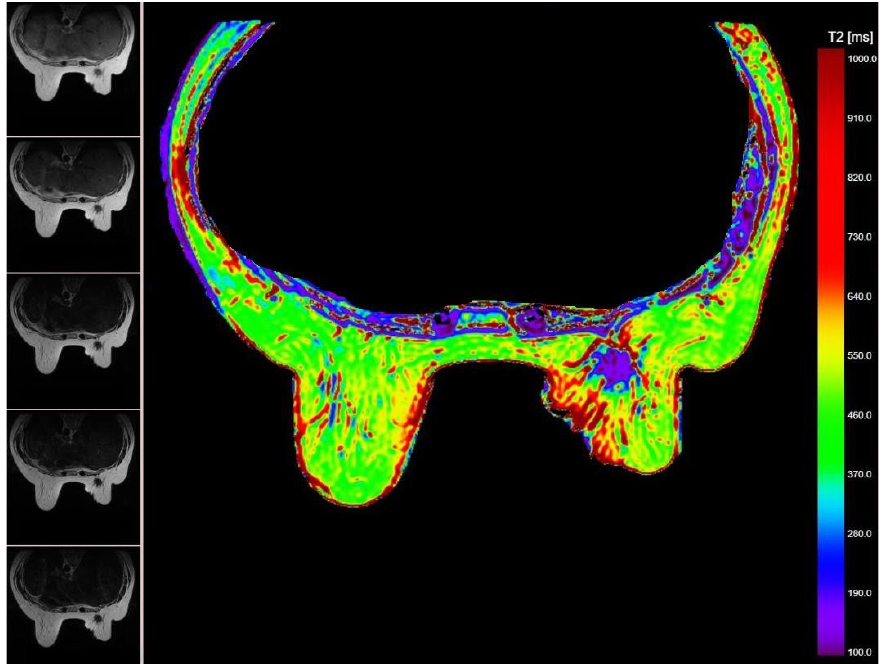
Figure 1. Breast MR relaxometry map (right image) showing a right sided breast carcinoma with different relaxometry values (purple; <190 ms) compared to adjacent breast tissue. The 5 different MR images used to obtain the relaxometry map are displayed on the left side. In addition, the T2 relaxometry processing derived the hydrogen proton density map (1H map), corresponding to each analyzed breast mass. Figure 2.